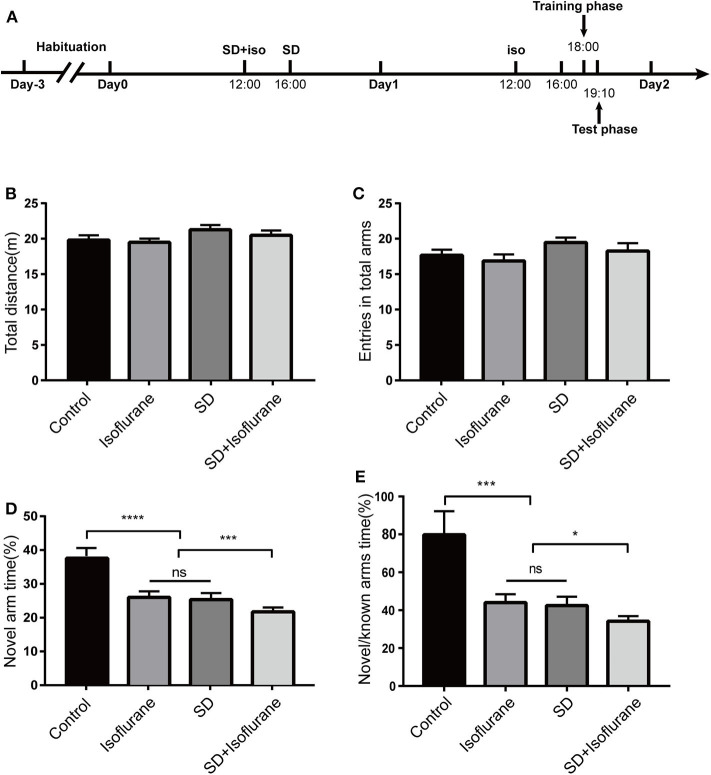
The Y-maze was used to assess short-term memory. Schematic showing the procedures for the time points that the experimental groups began to receive the treatments (A). Total distance (B), total arms entries (C), exploration time percent in the novel arm (D), and the time ratio of exploring the novel arm to the known arms (E). Values are expressed as mean ± SEM. ns: no significance. *P < 0.05, ***P < 0.001, ****P < 0.0001, one-way ANOVA and Tukey test, n = 10/group.